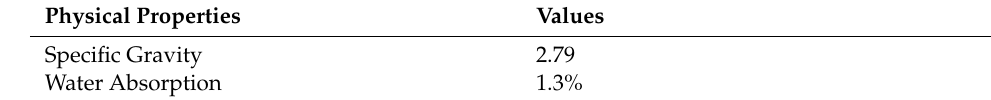
Table 3. Physical properties of fine and coarse aggregates.